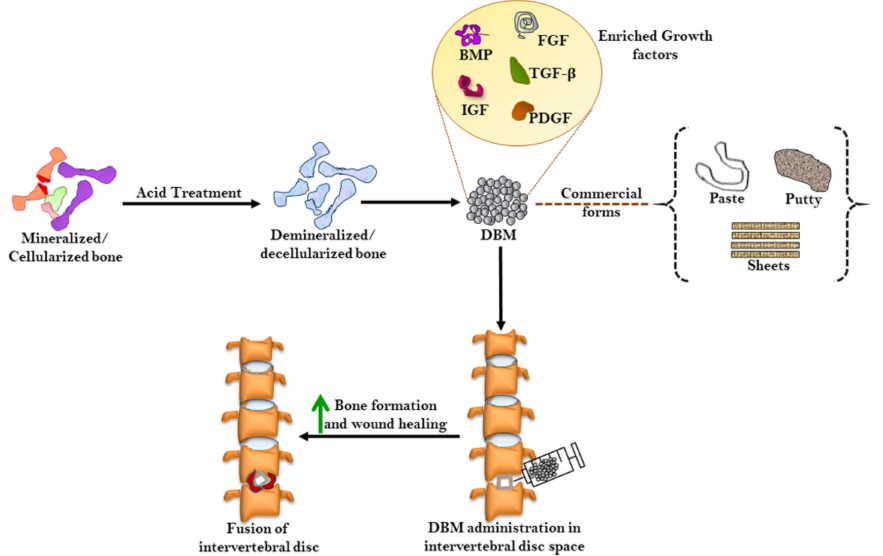
Figure 3. Strategies for synthesizing DBM. Following mild acid treatment, DBM is produced that contains various growth factors for tissue repair. The commercial forms of DBM include paste, putty, and sheets, which could be administered in an intervertebral disc space to assist wound healing and spinal fusion. DBM: Demineralized bone matrix, IGF: Insulin-like growth factor, PDGF: Platelet-derived growth factor, TGF: Transforming growth factor, FGF: Fibroblast growth